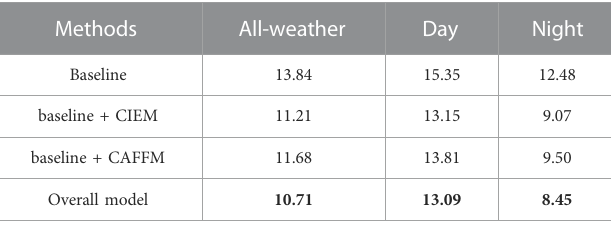
TABLE 4 MRs for ablation studies of the proposed method on SA.